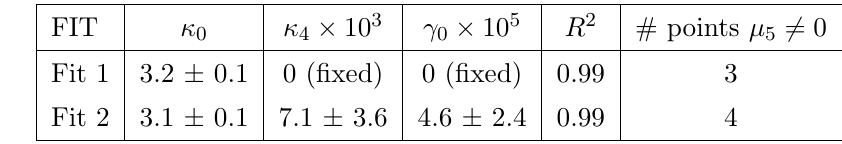
Figure 5 . Fits of (cid:26) 5 ( (cid:22) 5 ) using the chiral limit expression (5.49) for (cid:20) 2 = 0. The lattice points used for the (cid:12)t are those in [23].